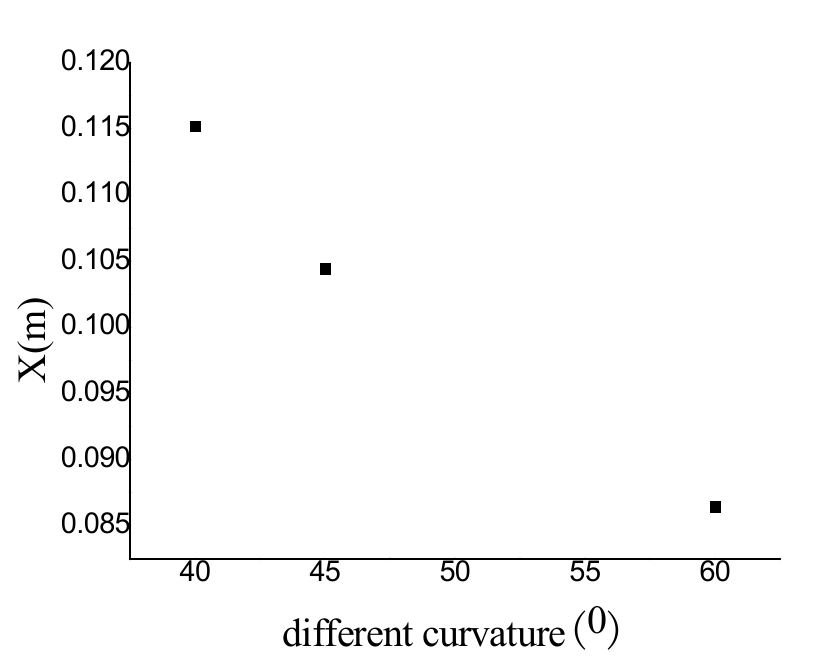
Figure 7. The change of quenching position with bend